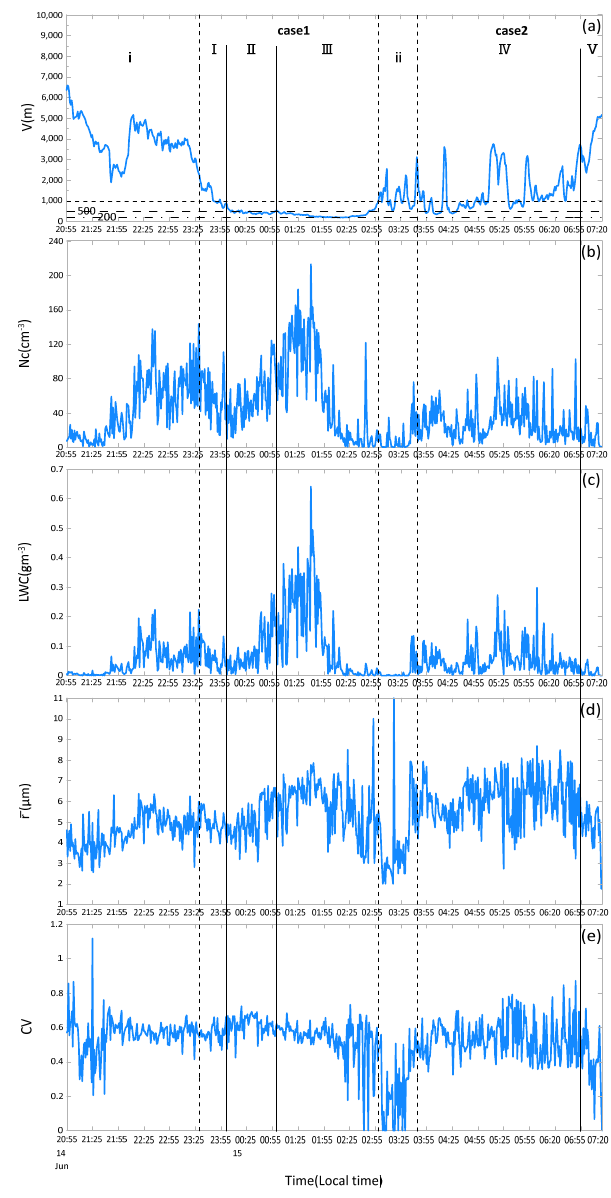
Figure 6. Example of the evolution of microphysical quantities. The example time is 20:55 on 14 June to 7:20 on 15 June. ( a ) V, ( b ) N C , ( c ) LWC, ( d ) 𝑟̅ , ( e ) CV. The lines in the figure represent the divisions of the stages.